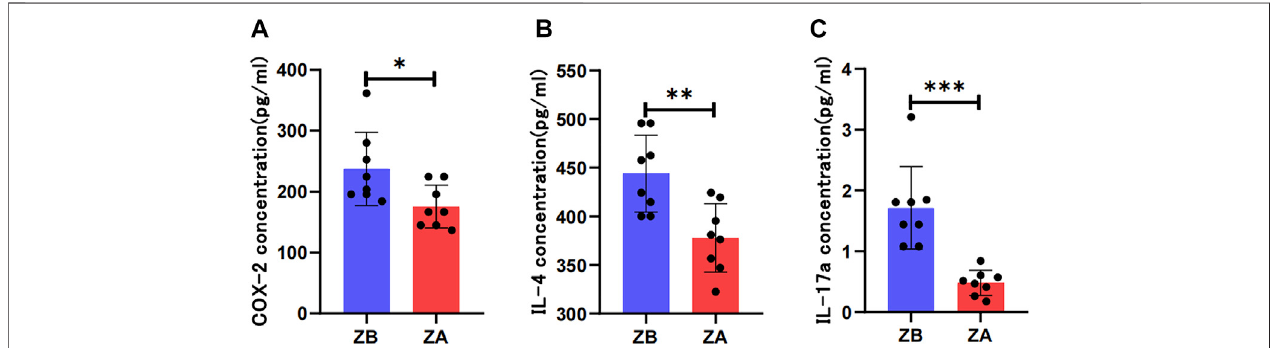
FIGURE 7 | ELISA detection of in fl ammatory factors before or after ZJP treatment in serum. ( (A) Expression of COX-2 in patients ’ serum; (B) expression of IL-4 in patients ’ serum; (C) expression of IL-17a in patients ’ serum; ZA, ZJP after treatment; ZB, ZJP before treatment).